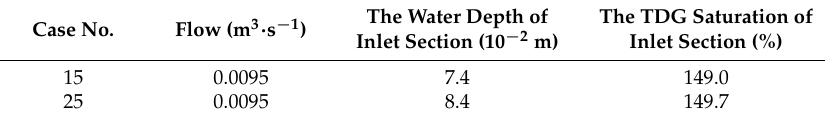
Table 4. The boundary conditions of the verification cases. Case